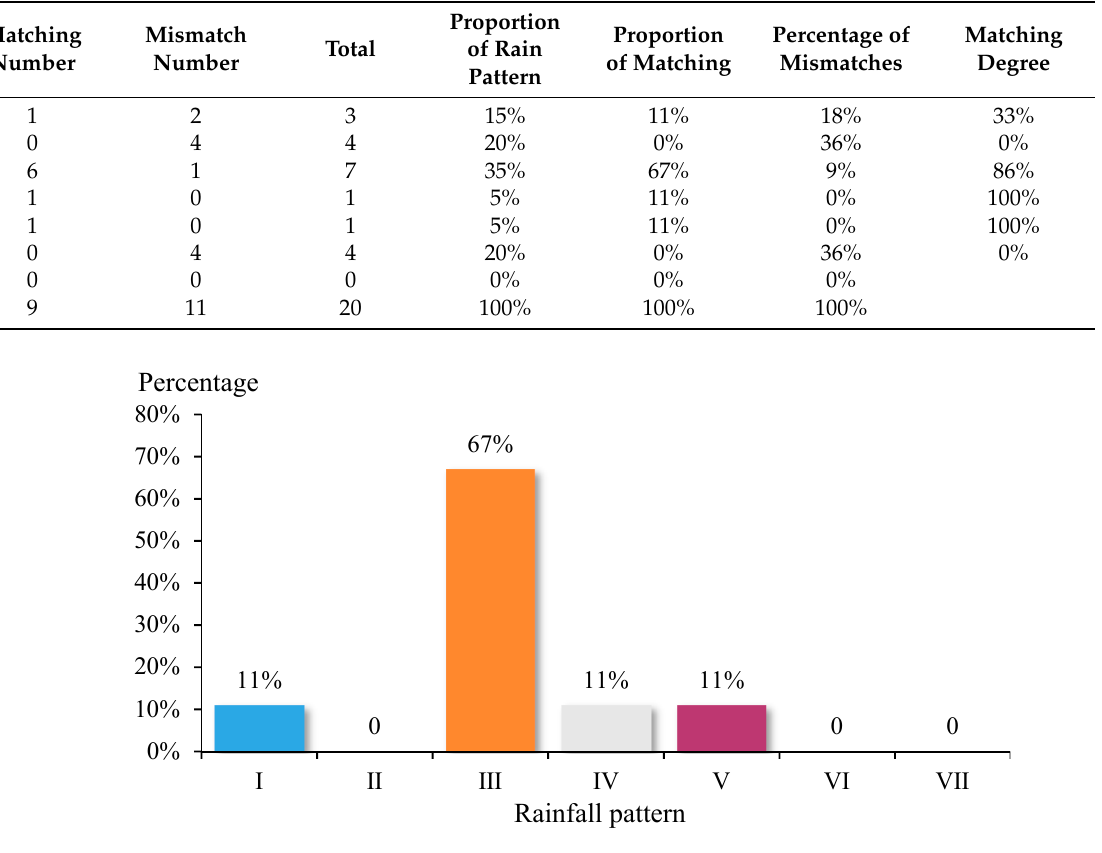
Table 7. Matching results of the rainfall patterns identified by two kinds of data.